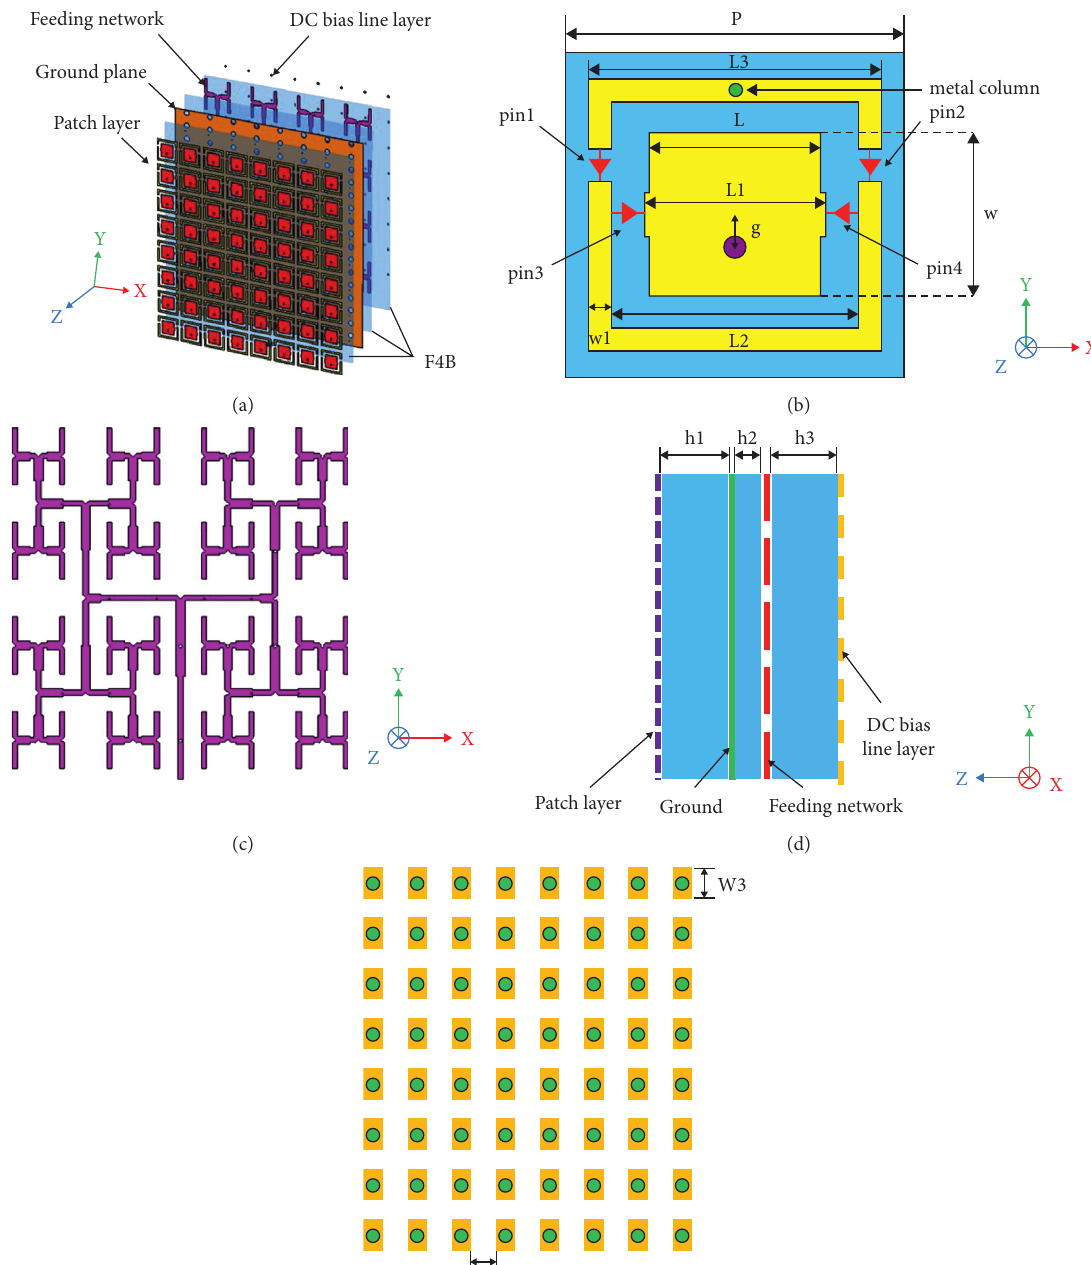
Figure 2: (a). Overall view of whole structure; (b) dimensions of proposed metasurface antenna unit including p � 15mm, g � 1.5mm, L � 7.6mm, L1 � 8 mm, L2 � 11mm, L3 � 13mm, and W � 7.5mm; (c) overall view of feeding network; (d) side view of whole structure where h1 � h3 � 1.6mm, h2 � 0.6 mm; (e) overview of DC power lines where W3 � 1mm, L4 �